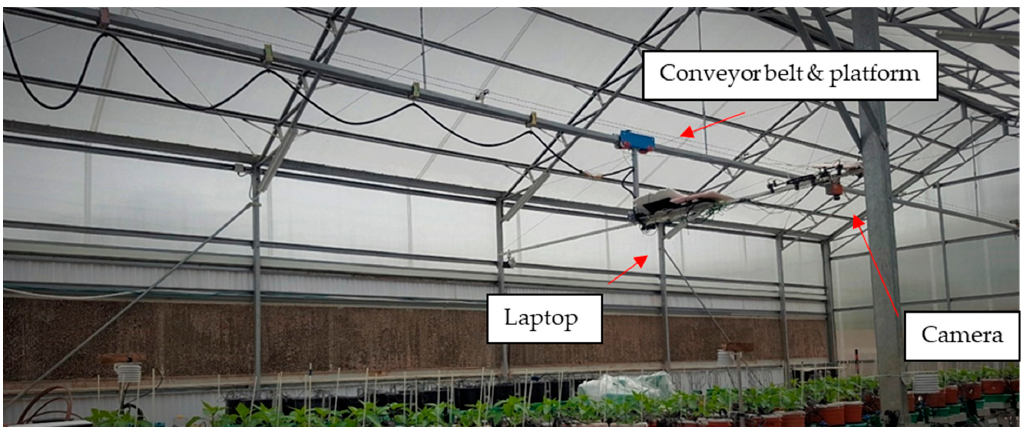
Figure 2. A view of the imaging platform as it moved above the plants. The platform was constructed from lightweight materials and deployed within just a few hours.